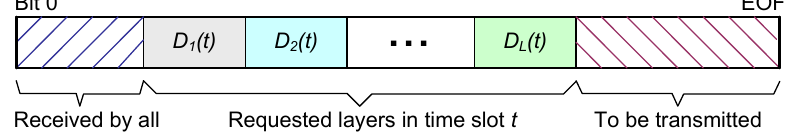
Figure 2. Superposition coding and successive interference